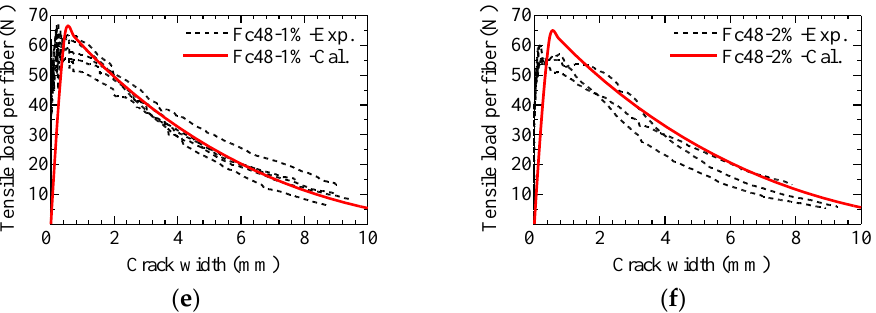
Figure 15. Comparison of tensile load-rack width curve between uniaxial tension test results and bridging law calculation: ( a ) Fc24-1%; ( b ) Fc24-2%; ( c ) Fc36-1%; ( d ) Fc36-2%; ( e ) Fc48-1%; ( f ) Fc48-2%.